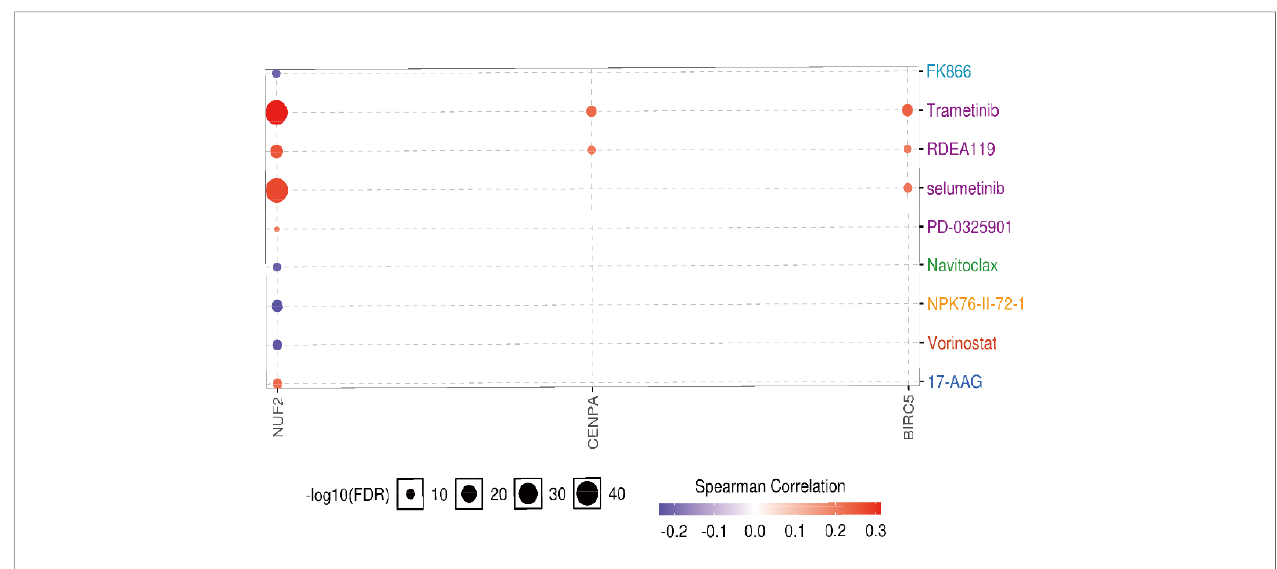
FIGURE 12 | The drug resistance analysis of hub genes based on GDSC IC50 drug data. Correlation between gene expression and the drug is represented by Spearman correlation, and positive correlation means that high expression is associated with drug resistance.